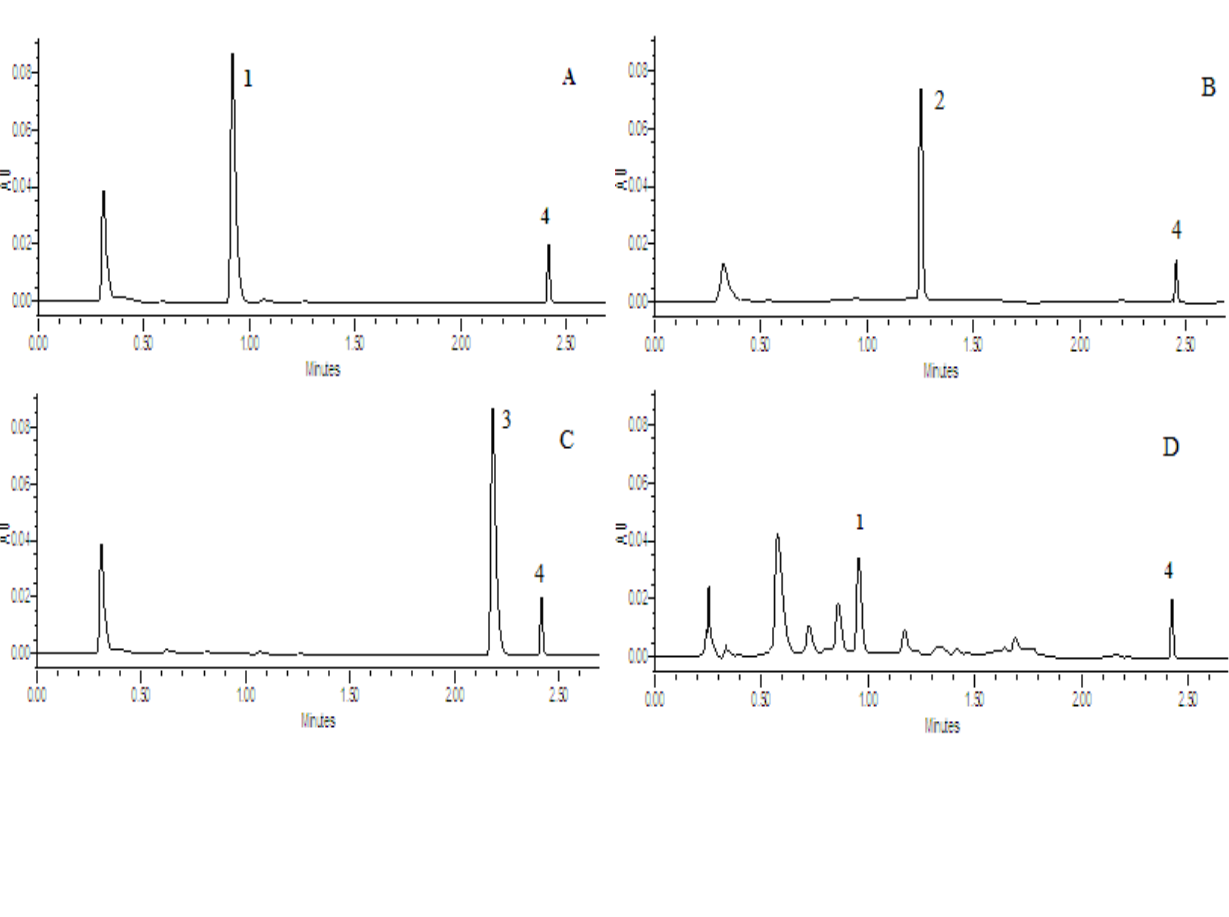
Figure 2. UPLC chromatograms of compounds transported across Caco-2 cell